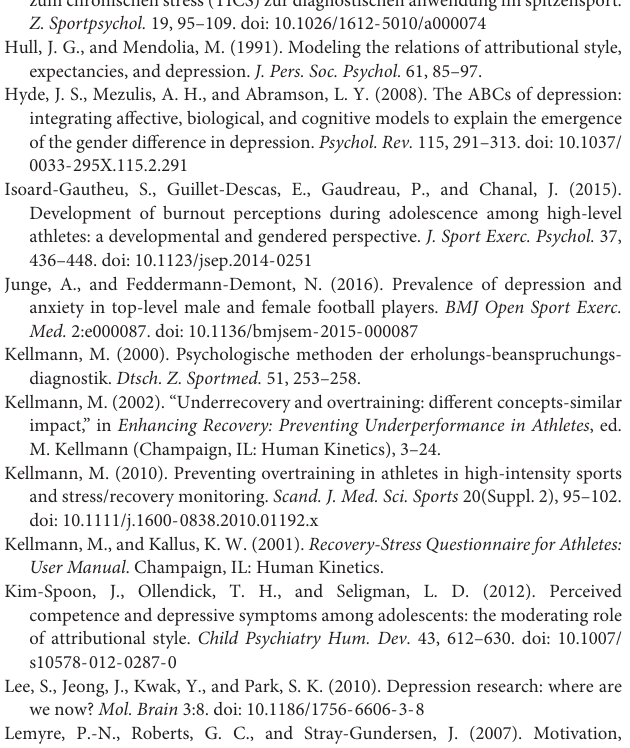
athlete burnout among young table tennis players: a 3-wave study. J. Sport Health Sci. (in press). doi: